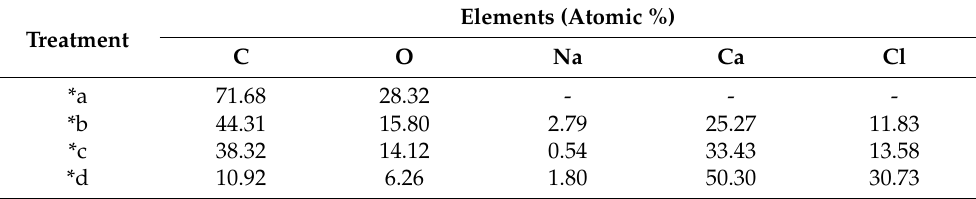
Table 4. Atomic percentages of different elements in the cotton/elastane samples.